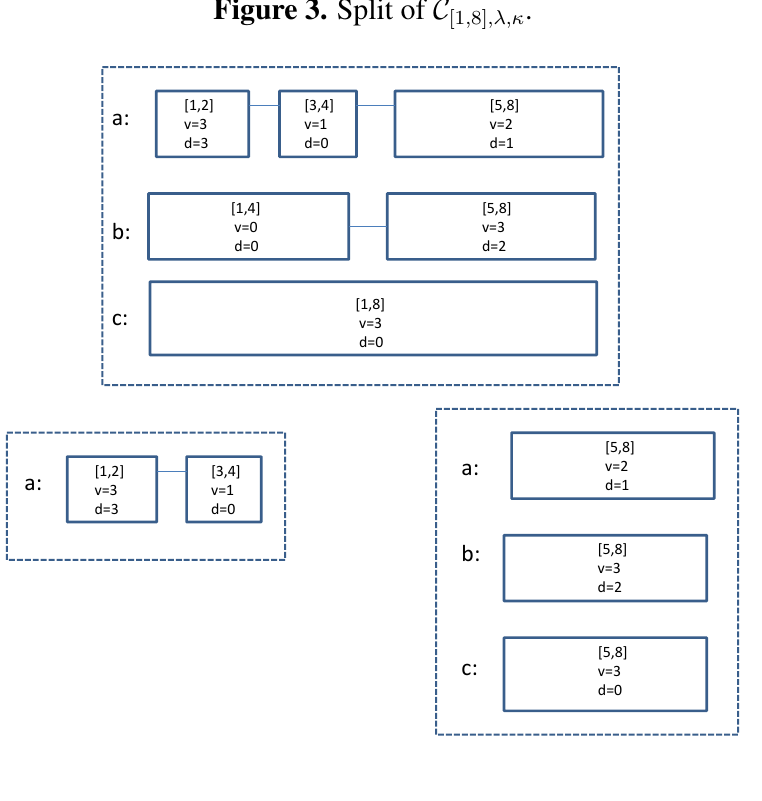
Figure 3. Split of C